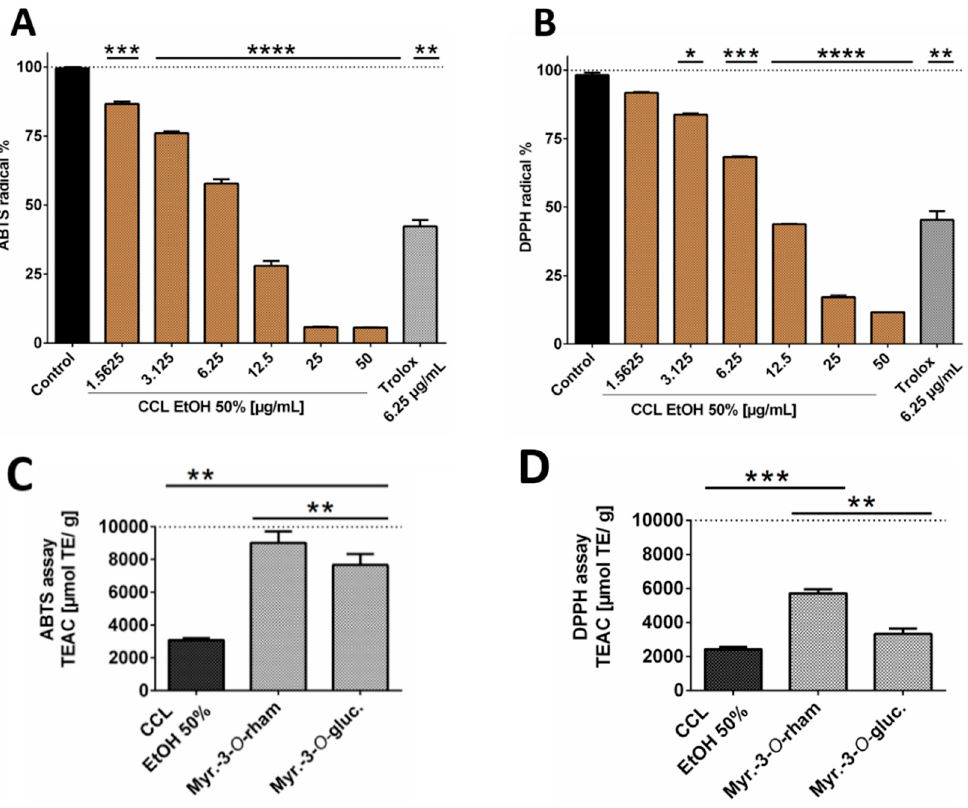
Figure 3. Antioxidant activity of 50% ethanolic extract of C. collinum extract, measured by ABTS ( A ) and DPPH assays ( B ). CCL EtOH 50% showed significant concentration-dependent antioxidant activity compared to control (pure ABTS or DPPH solution incubated with a blank). Trolox 6.25 µ g / mL was used as a positive control. The two diagrams C and D show that the two main compounds of the extract had significantly higher antioxidant activity than CCL EtOH 50% in both the ABTS ( C ) and the DPPH assays ( D ) and thus most likely significantly contributed to the overall antioxidant activity of the extract; values in ( C ) and ( D ) are given in Trolox Equivalent Antioxidative Capacity (TEAC). n = 3 replicates, data presented as mean ± SEM, significant for * p ≤ 0.05, ** p ≤ 0.01, *** p ≤